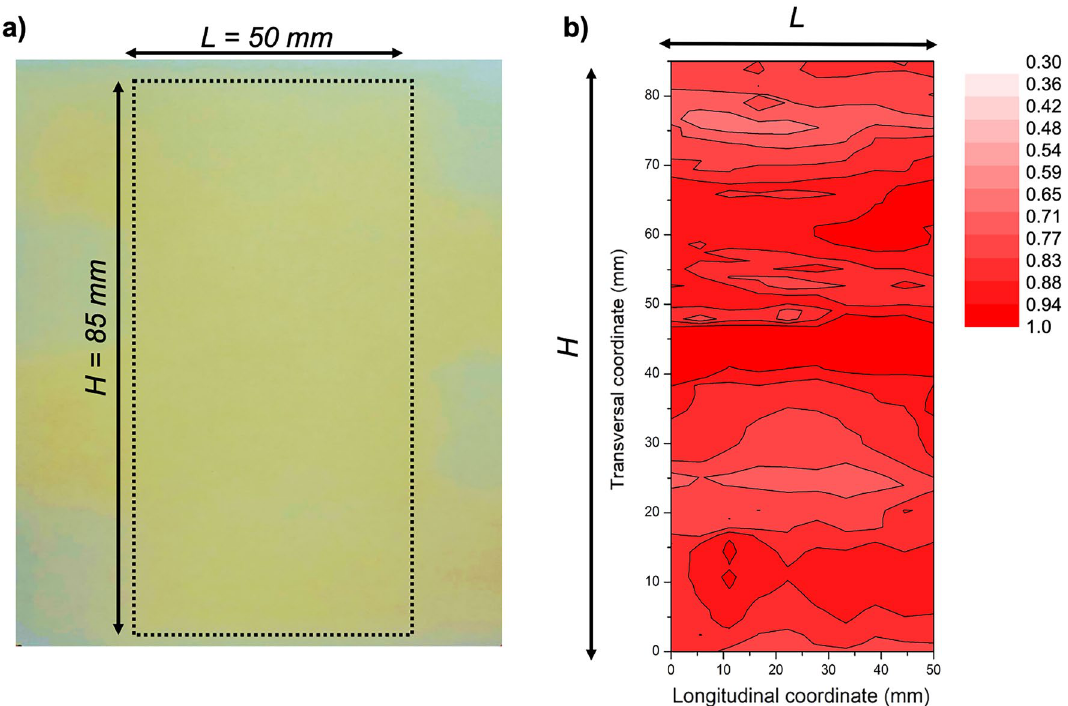
Figure 11. Example of nanoparticles deposit on the large surface area using four aerodynamic lenses, with 30 nm Si nanoparticles. ( a ) Deposition on a paper substrate with the lateral motion of the substrate holder. ( b ) Relative thickness map of the deposit realized in the same conditions on a transparent substrate (color scale corresponds to the relative thickness). The relative thickness variation is below 8% over the whole